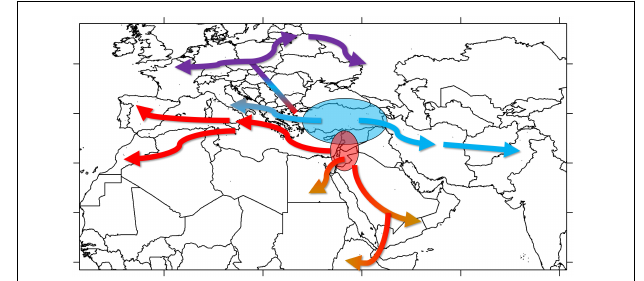
FIGURE 6 | Model proposed for the spread of lentil cultivation based on genomic